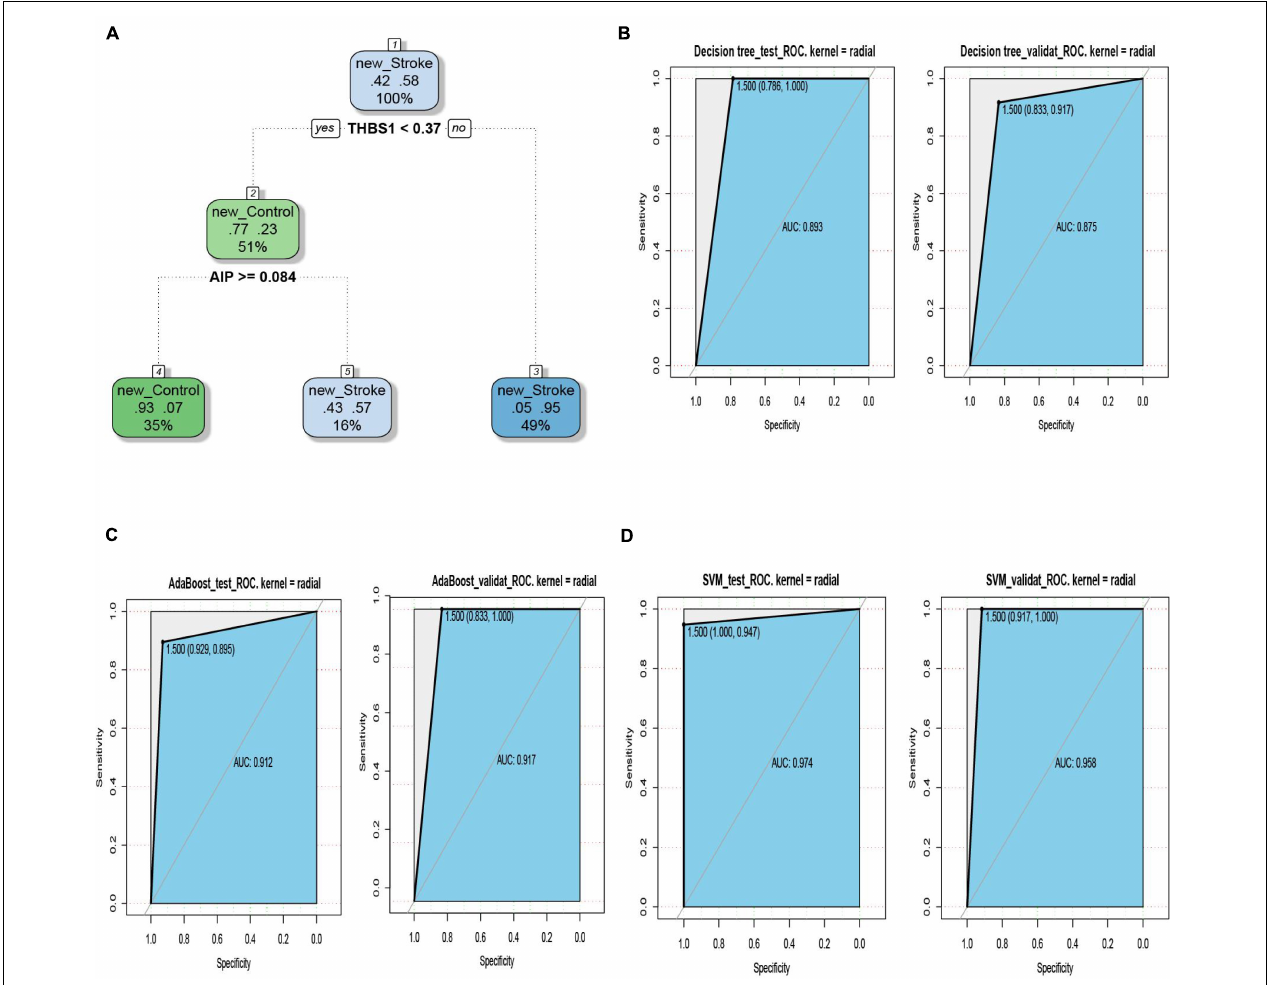
FIGURE 7 | The decision tree diagram of the classifier model (A) . ROC curves of the test and validation sets of three classifiers; Decision tree (B) , AdaBoost (C) and SVM (D)